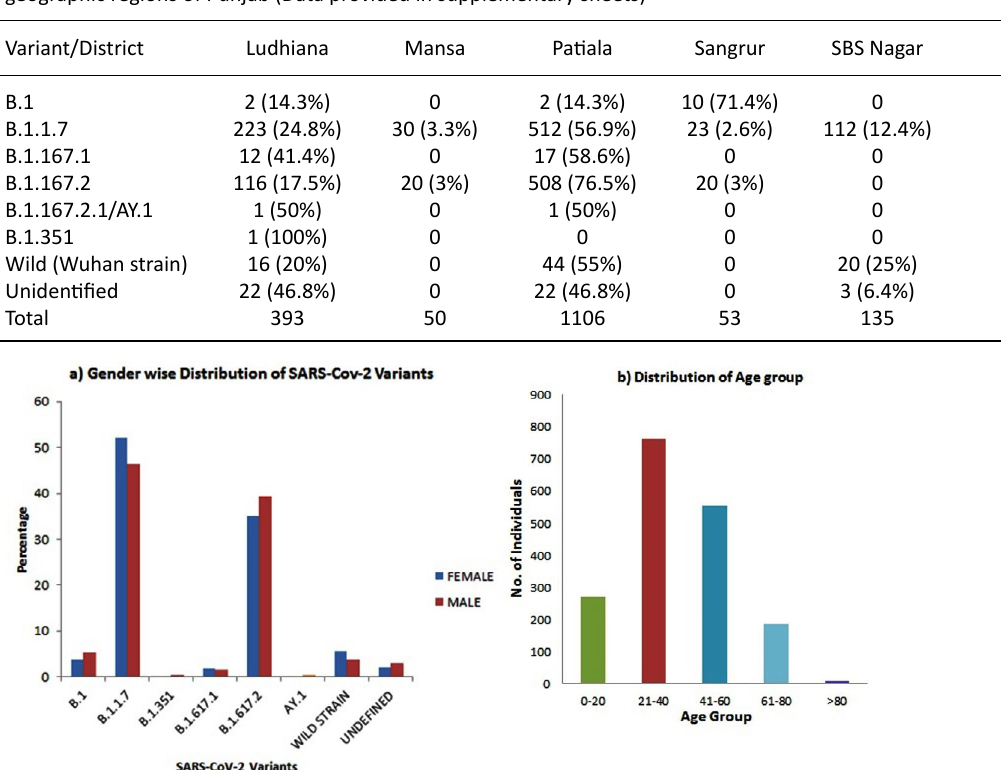
Fig. 4. Bar graphs showing frequency of SARS-CoV-2 variants B.1, B.1.1.7, B.1.351, B.1.617.1, B.1.617.2, Wild/ Wuhan strain, unidentified variant. a) Among different genders b) Among different age group of Malwa region in Punjab, India. The occurrence of B.1.1.7 variant in male and female is 46.5% and 52% respectively. The variant B.1.617.2 (Delta Indian variant) is the second highest among the population studied as the percent occurrence of this variant among male and female is 39.5% and 35% respectively. In all the age groups the dominant variant was B.1.1.7 (UK variant) followed by B.1.617.2 (Delta Indian variant) and the other variants were equally distributed in all the age